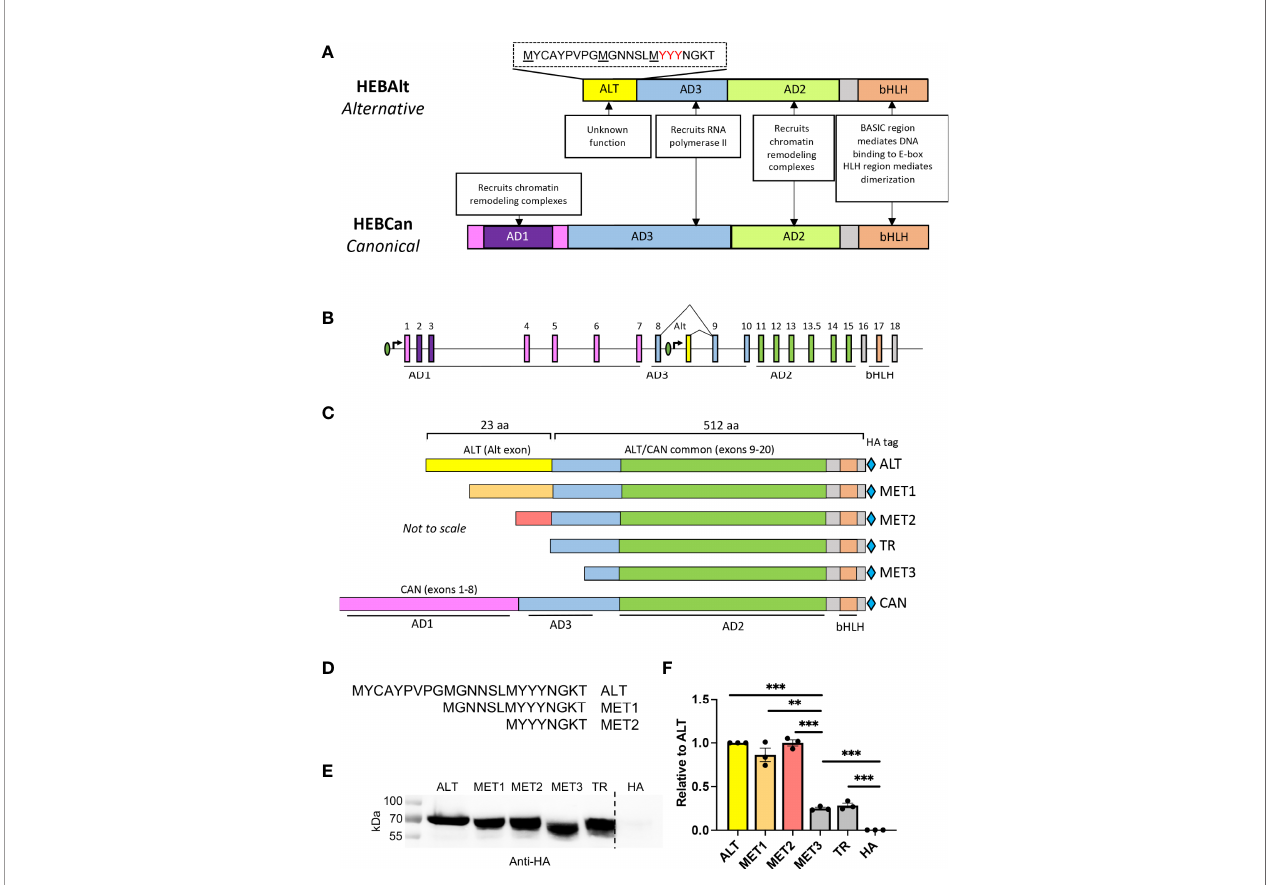
FIGURE 1 | The Alt domain is required for HEBAlt transcriptional activity. (A) Diagram of HEBAlt (alternative) and HEBCan (canonical) variant domain structures and functions. AD=activation domain, bHLH = basic DNA binding and helix-loop-helix dimerization. ALT = domain speci fi c to HEBAlt, with amino acid sequence shown above it. (B) Structure of the TCF12 gene locus that encodes both HEBCan and HEBAlt by alternative transcriptional initiation and splicing. Introns = straight line, exons = boxes, promoters = ovals. Exons encoding the functional domains are indicated under the locus and in colors corresponding to (A) . (C) Domain structures of HEBAlt WT (ALT), MET1, MET2, TR, MET3, and HEBCan (CAN). Domains are color coded to match (A, B) . Light blue diamonds = HA epitope tag. (D) Amino acid sequence of the wildtype (ALT) and mutated Alt (MET1, MET2) domains. MET3 and TR lack the ALT domain entirely. (E) Western blot showing protein expression of wildtype and mutant HEBAlt construct expression as detected by anti-HA. HA indicates HA vector-only control (F) . Dual luciferase assay on cells co-transfected with HA-tagged ALT, MET1, MET2, MET3, or TR, plus 8X E box Fire fl y luciferase and Renilla luciferase constructs. The Y-axis depicts relative luciferase units (RLU) of Fire fl y to Renilla values, normalized to ALT. ***P ≤ 0.0001, **P ≤ 0.001, ns = non-signi fi cant. Note that in (E) , some lanes from the same gel are depicted separately, as they were cut and pasted back together from the original image to exclude irrelevant data. None of the domain or construct diagrams are to